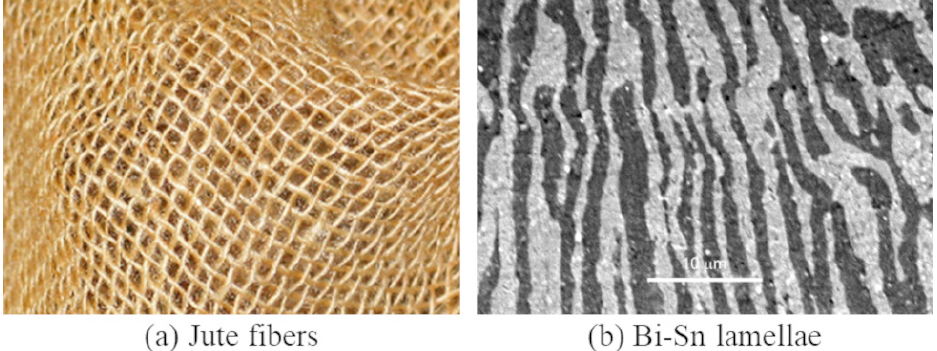
Figure 1. Examples of human and nature intertwining materials: ( a ) Jute fibers are interlaced to form a tenacious cloth. ( b ) The lamellar microstructures of a Bi-Sn system are composed of alternating layers of bismuth (white) and tin (black) ©2003 by Charles and Cockburn (CC BY-NC-SA 2.0